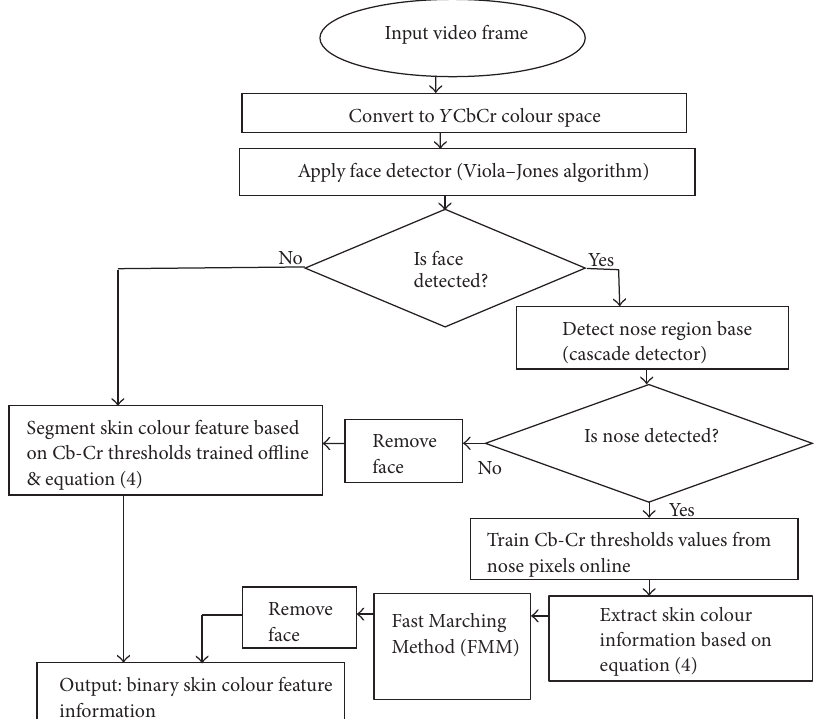
Figure 1: Skin colour segmentation scheme.